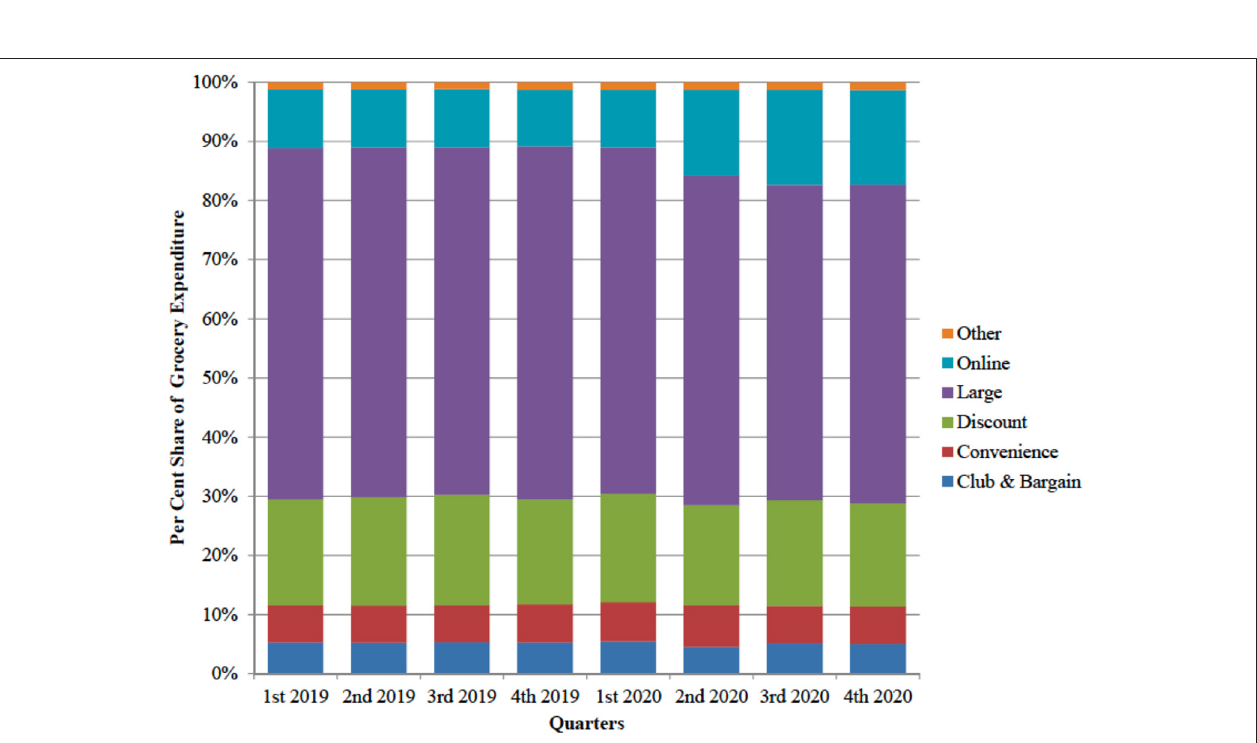
FIGURE 2 | Distribution of UK households by class of per-cent change in per capita expenditure for grocery goods before and after COVID-19 lockdown (per cent frequencies).